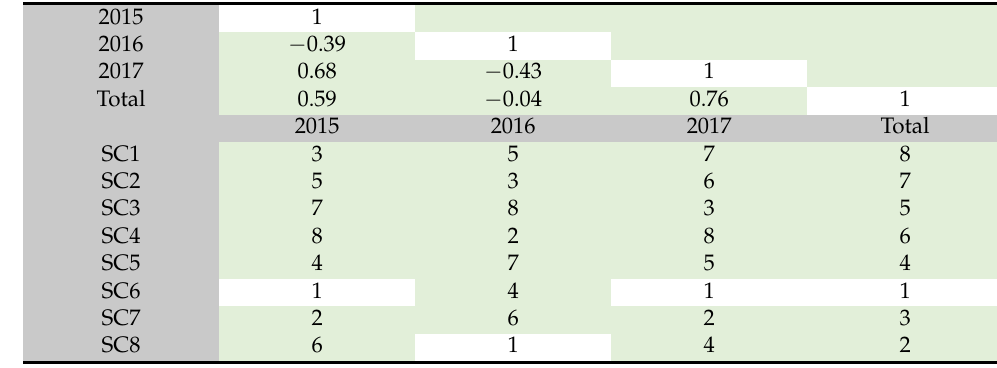
Table 4. Multicriteria assessment of the best